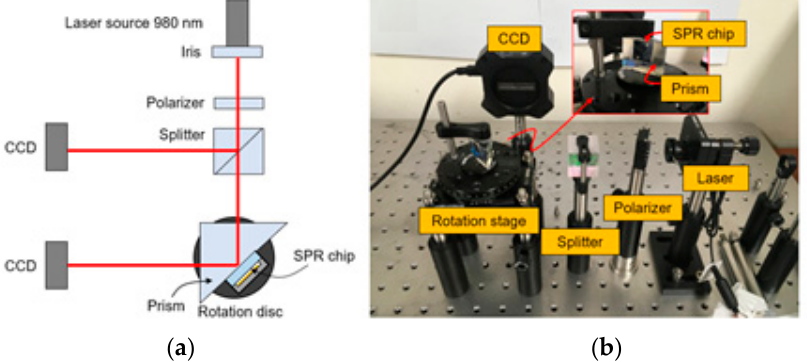
Figure 7. SPR measurement setup ( a ) schematic view; ( b ) measurement setup and fabricated SPR sensor chip.